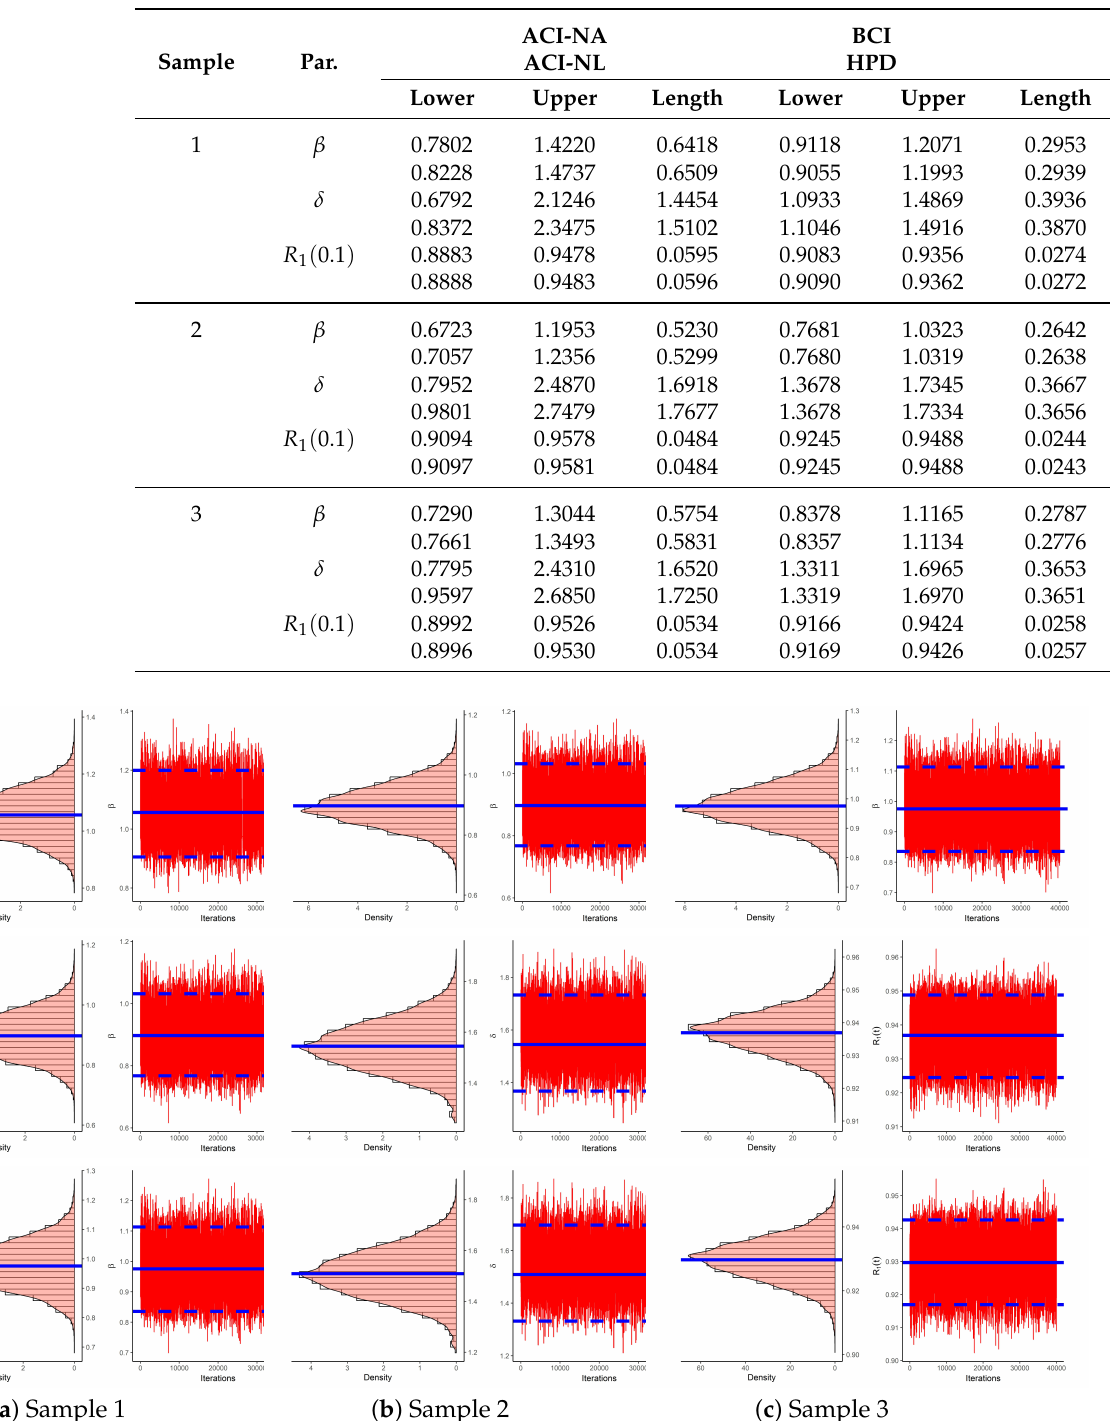
Table 10. Interval estimates of β , δ and R 1 ( t ) from LED data.